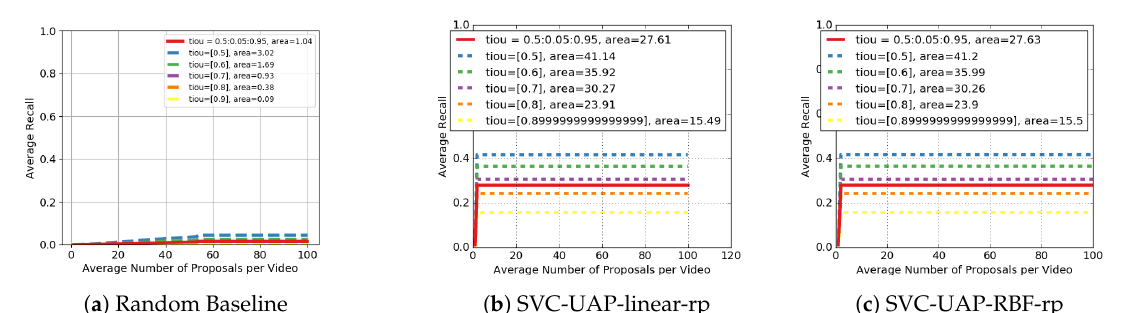
Figure 7. Performance in terms of AR-AN for the problem of Action Proposals in AcivityNet dataset. Comparison of the proposed approach with different kernels for the SVC module, including the random